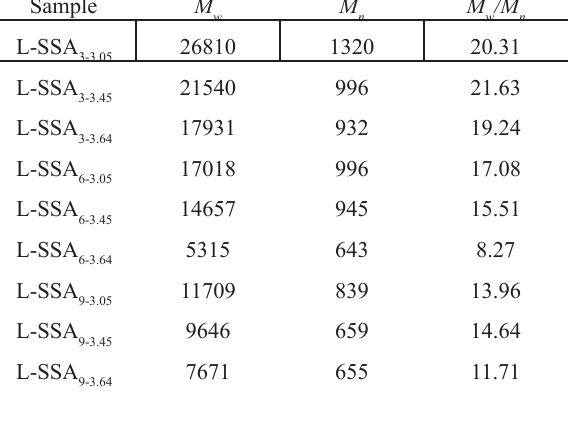
Table 4 – GPC results of L-SSA isolated from corncob Sample M